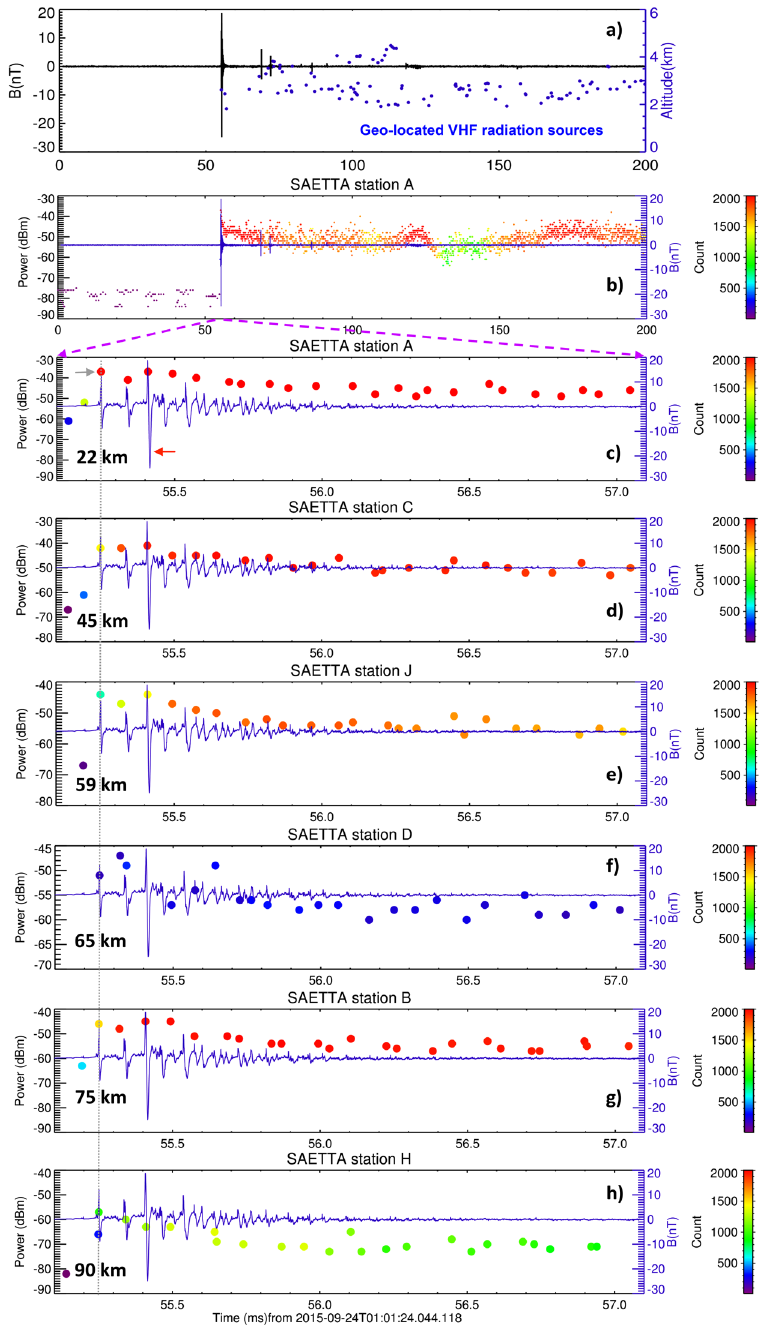
Figure 4. Example of an isolated breakdown event from the 2015 dataset. The same as in Fig. 3 but for a sequence of PBPs and VHF intra-cloud activity on 24 September 2015, 01:01:24.0 UTC, 9.45°E, 42.80°N. Red arrow shows the largest pulse in this sequence which has also been detected by